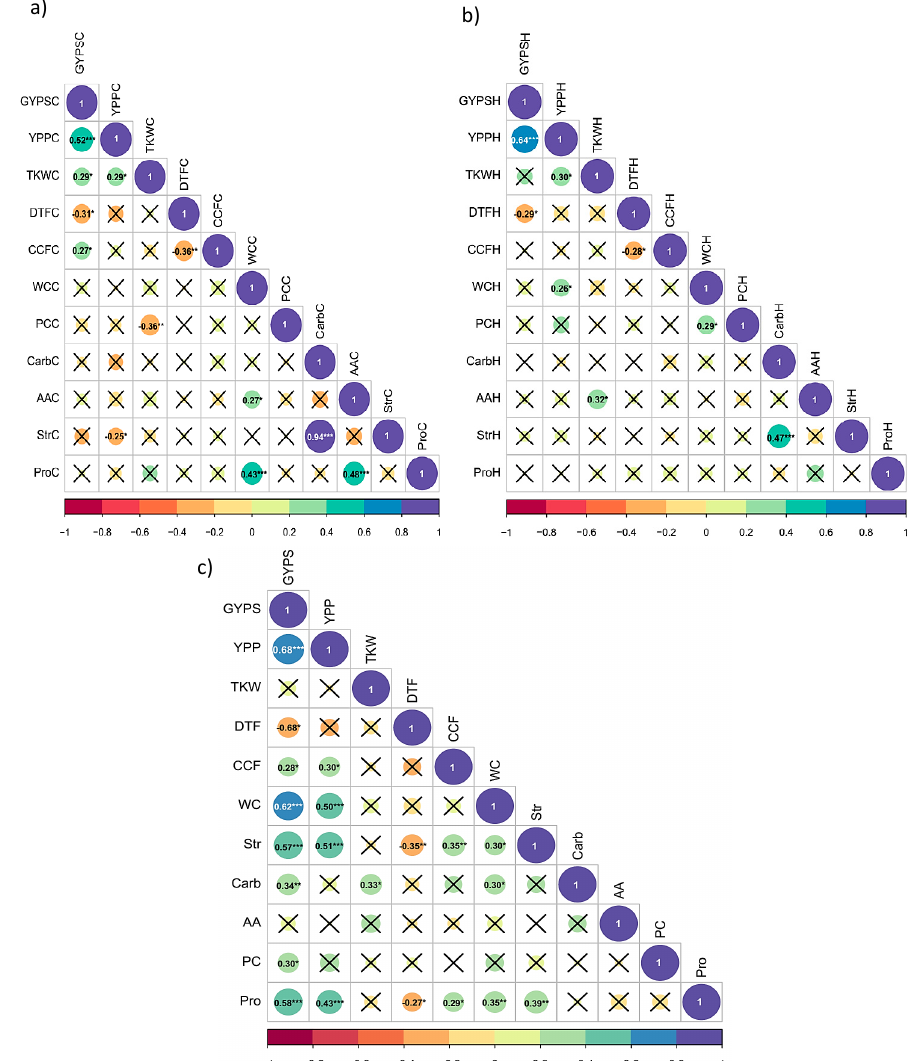
Figure 4a,b: Correlation of traits in barley a) under control b) under heat stress during pre- anthesis in barley. The full names and abbreviations of the traits are listed in Table 1. X indicates the non-significant correlations at p = 0.05